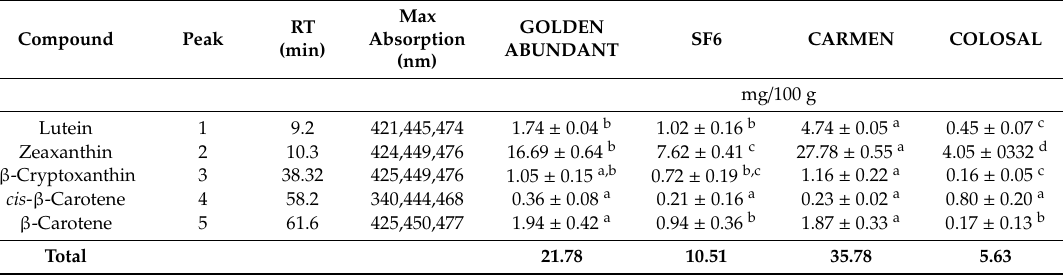
e ff ective flavonol glycosides in terms of free radical scavenging activity are isorhamnetin, quercetin, and